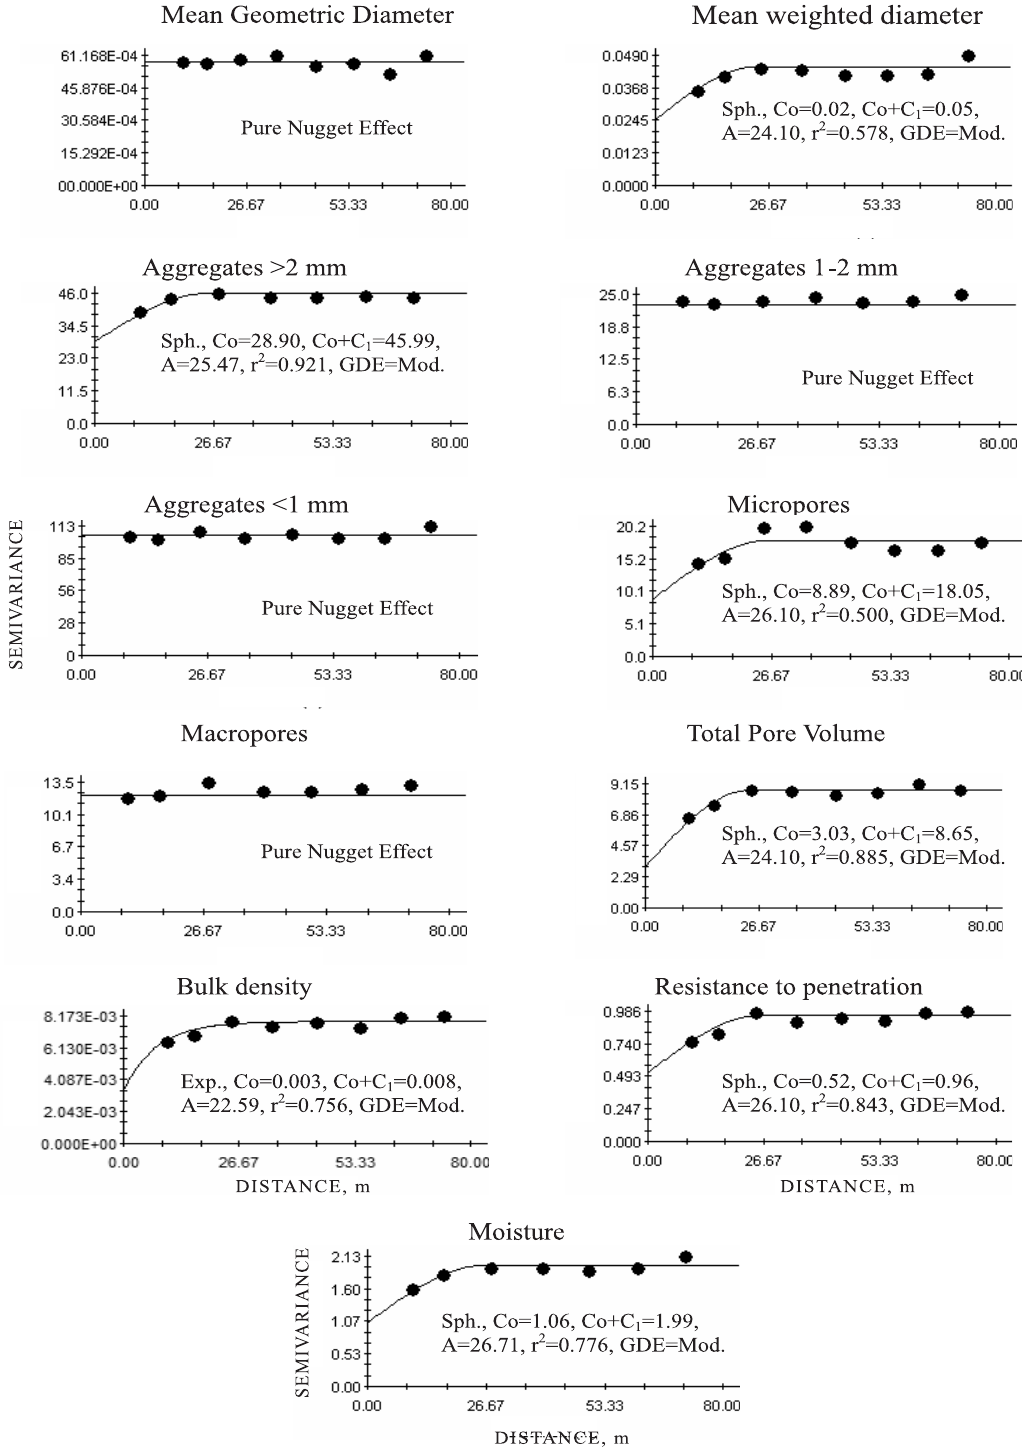
Figure 2. Semivariograms of the studied attributes of the convex area (0–0.2 m). Exp.: exponential; Sph.: spherical; Co: nugget effect; C sill; a: range (m); r 2 = coefficient of 1: